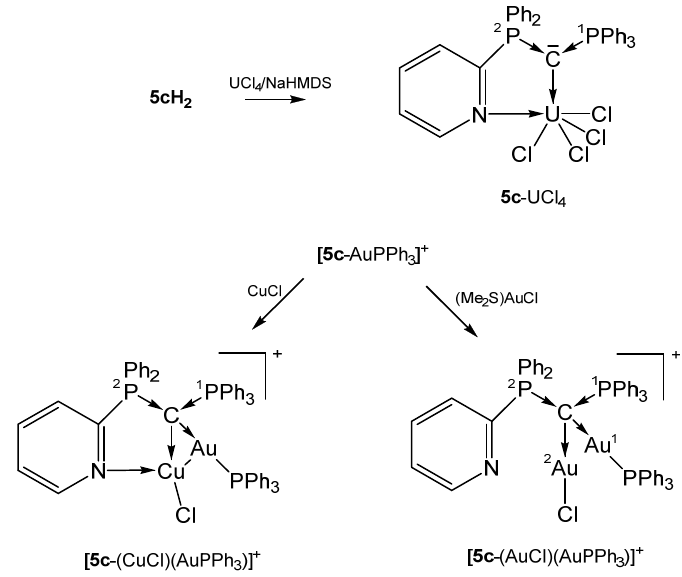
Scheme 13. Selected structures of transition metal complexes with the mono pyridyl substituted carbone 5c.